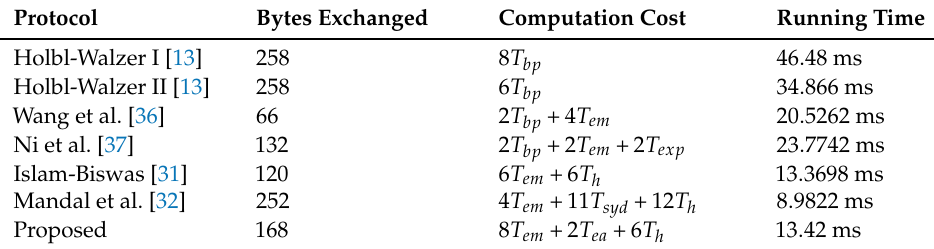
Table 3. Communication and Computation